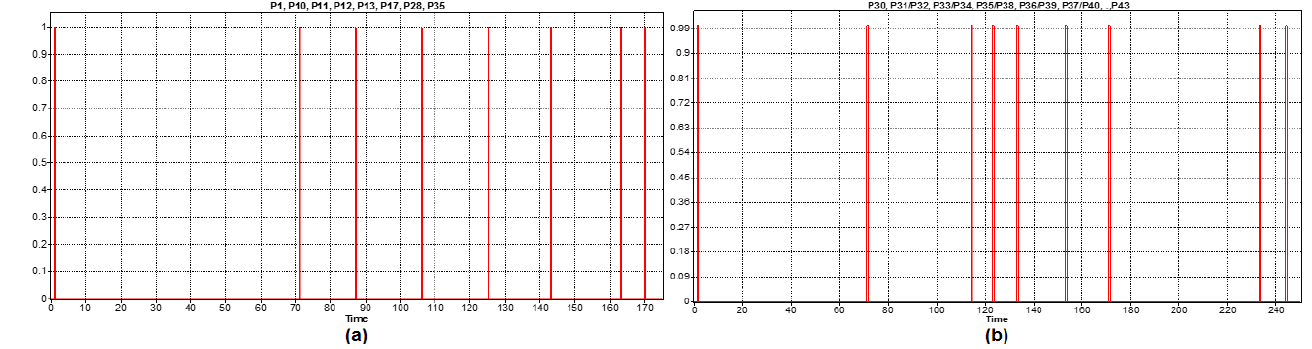
Figure 14. Monitoring signals for assembly operation steps from PN Sirphyco simulation: ( a ) WP 1, ( b ) WP 2.